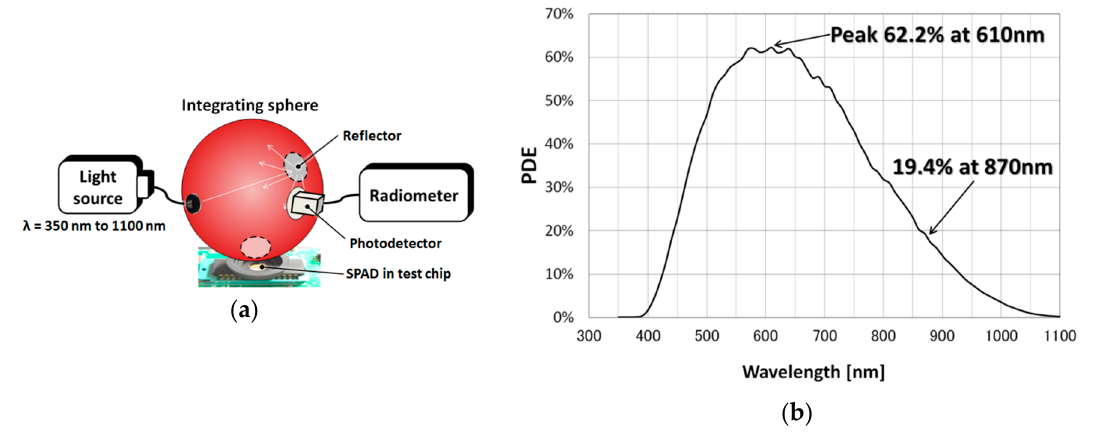
Figure 6. Measurement system ( a ) used to determine the PDE of the proposed SPAD. This system consists mainly of a light source, an integrating sphere, and a photodetector connected to a radiometer; ( b ) PDE as a function of light wavelength at an excess bias of 5 V.